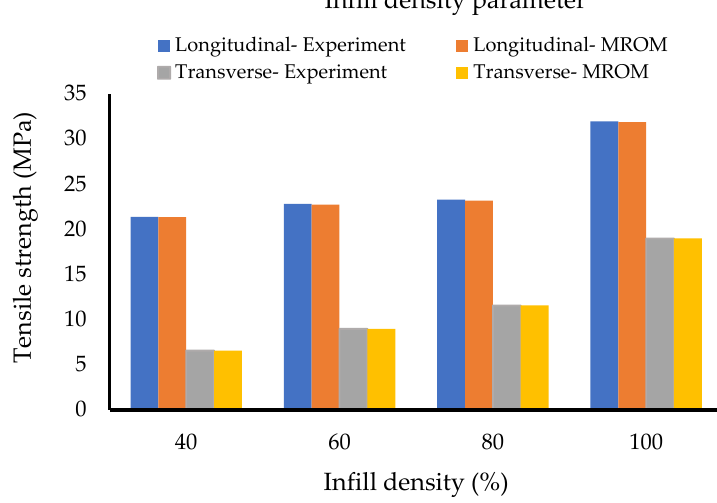
Figure 14. Infill density set (MROM).